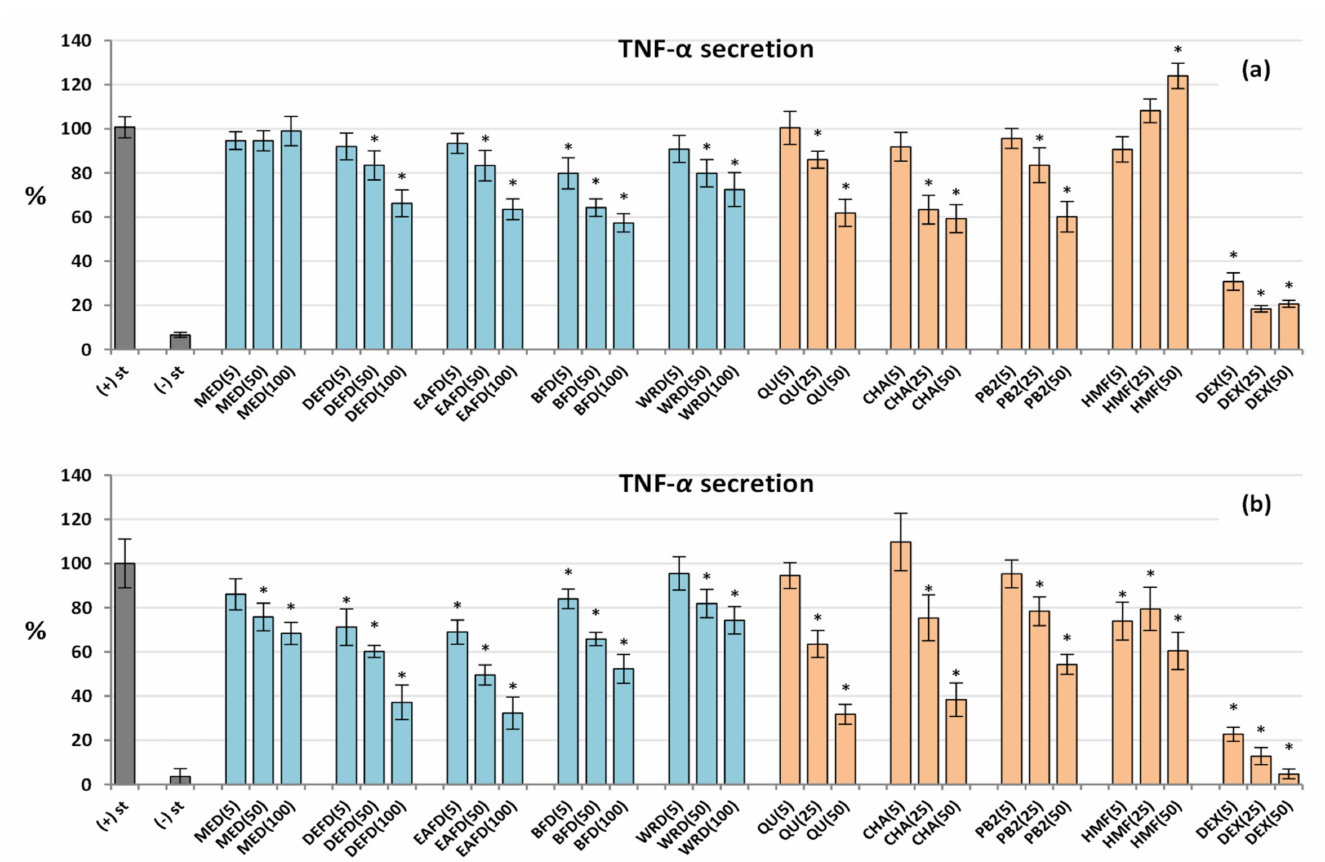
Figure 5. Effect of fruit extracts/fractions (1–100 µ g/mL) and standards (5–50 µ M) on the release of tumour necrosis factor α (TNF- α ) from stimulated human immune cells: ( a ) neutrophils; and ( b ) PBMCs. Standards: QU, quercetin; CHA, chlorogenic acid; PB2, procyanidin B2; HMF, 5- Hydroxymethylfurfural. Positive control: DEX, dexamethasone. For extracts codes see Table 1. Data expressed as means ± SD of five independent experiments performed with cells isolated from five independent donors. Statistical significance in Dunnett’s test: * p < 0.05 compared with the stimulated